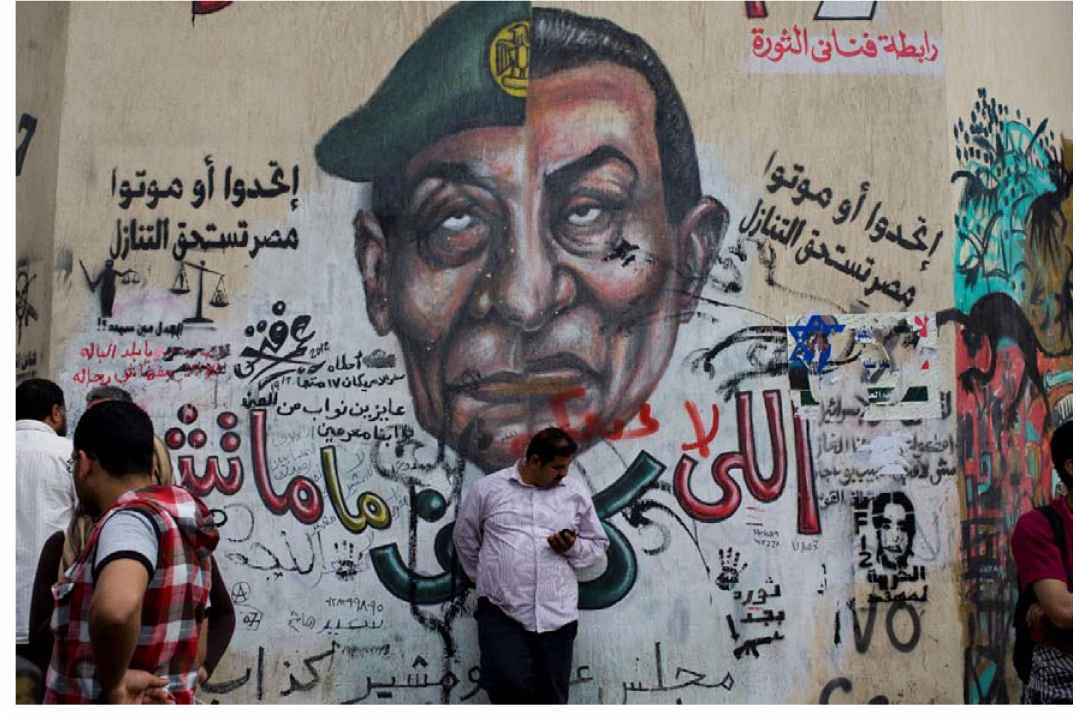
Figure 1 Political graffiti near Tahrir Square in Cairo following the 2011 revolution (Source: Pierluigi Mulas/Redux Pictures,